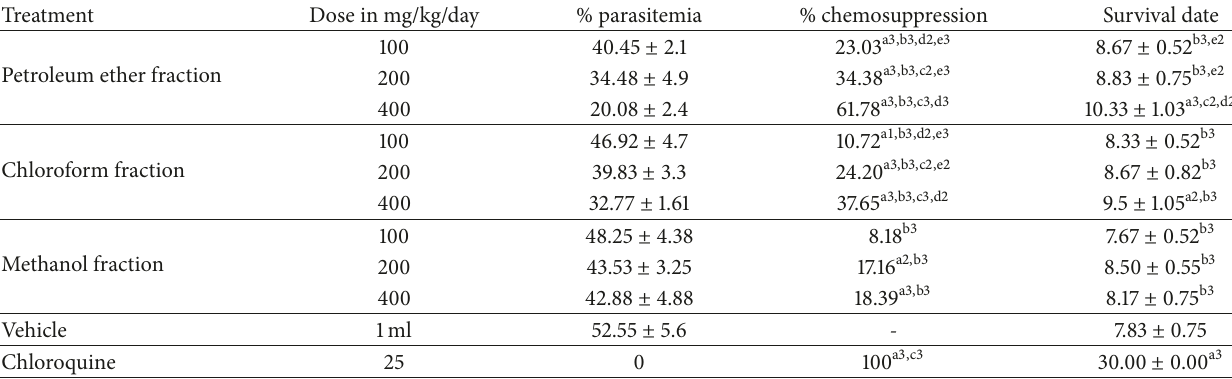
Table 1: Effect of the solvent fractions of C. papaya fruit rind on parasitemia and survival of P. berghei infected mice on 4-day Peter’s suppression